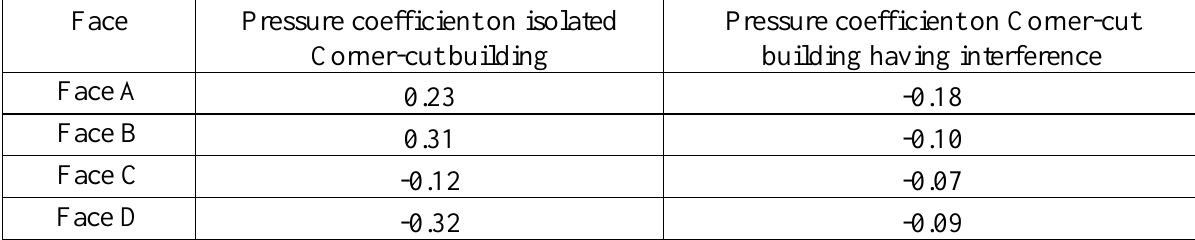
Mean pressure coefficient on corner-cut building, with and without interference at 0° wind incidence angle.